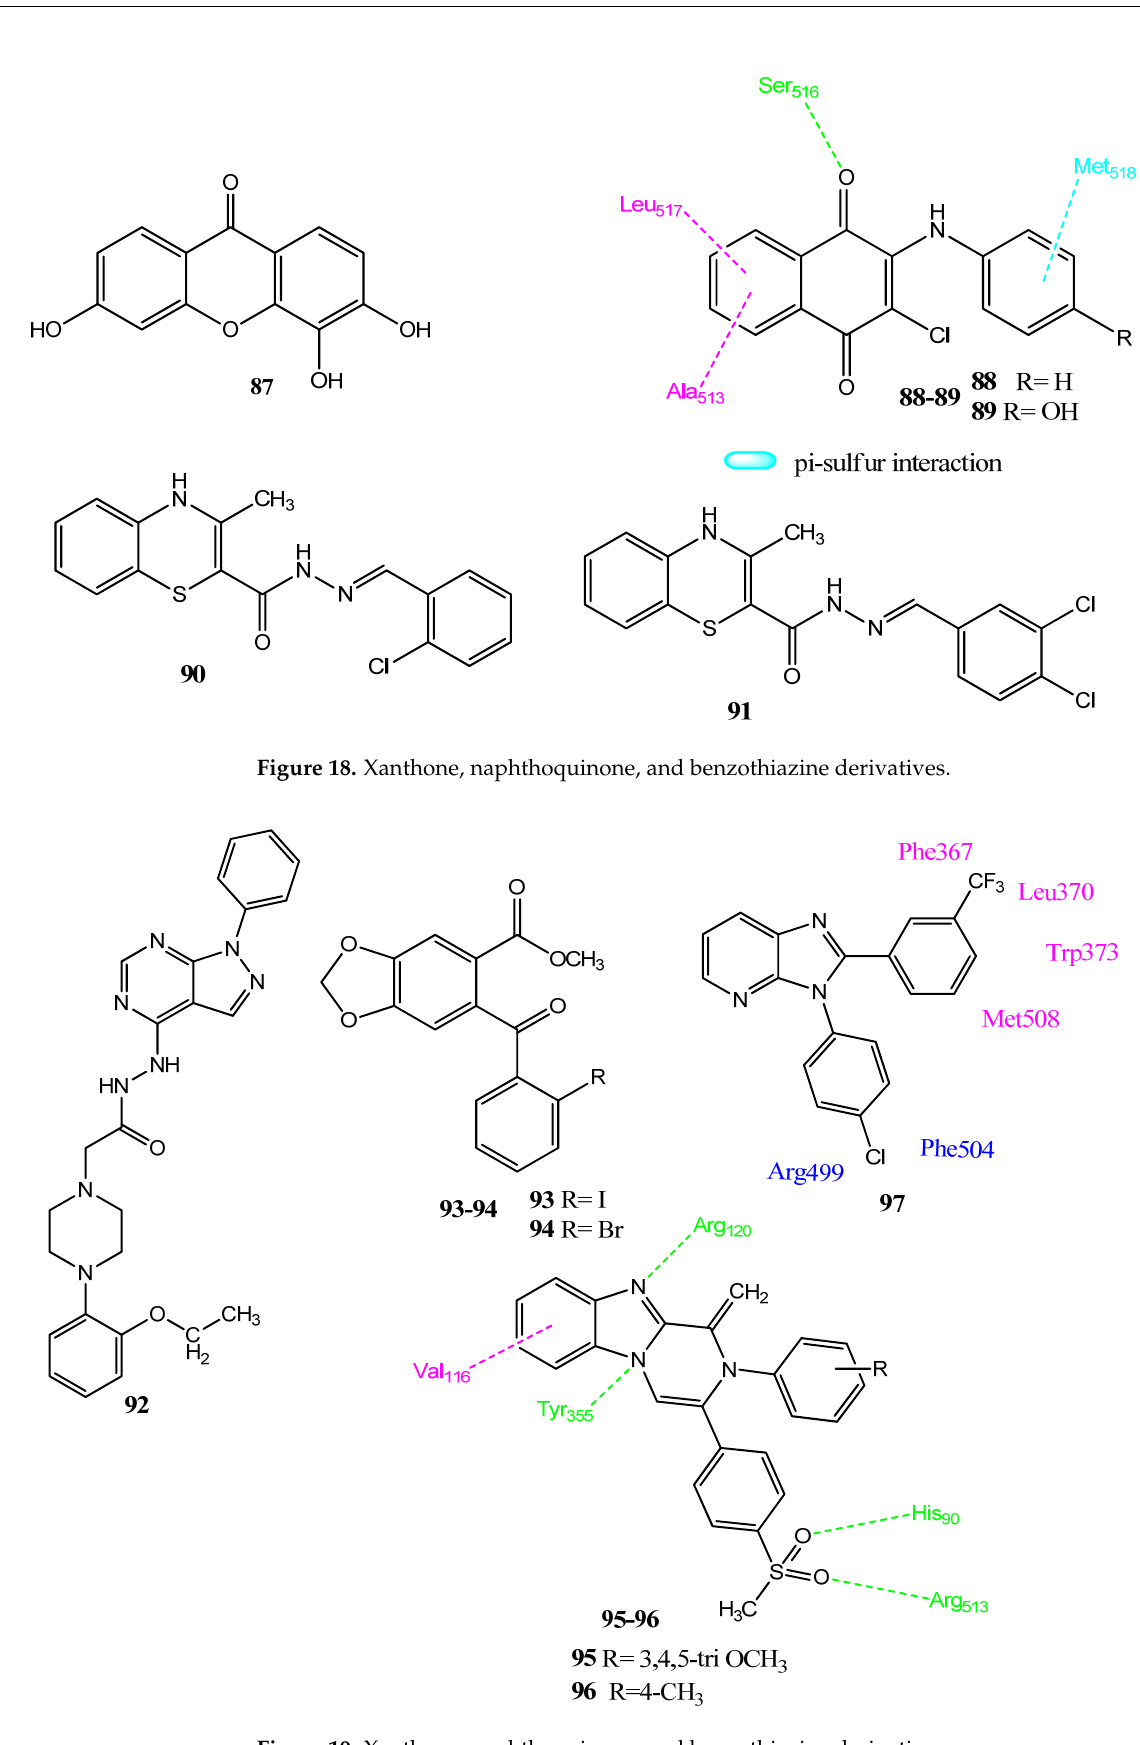
Figure 19. Xanthone, naphthoquinone, and benzothiazine derivatives.